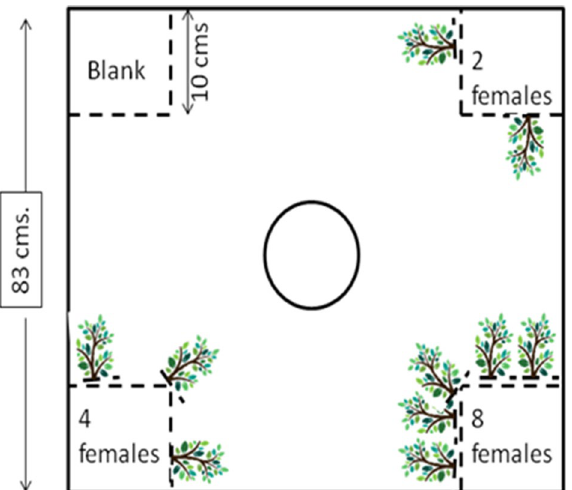
Figure 2. Diagrammatic representation of the arena the vegetation experimental set-up. The central chamber (indicated by a circle) represents the area where the test males were released and the corner square chambers (separated by transparent mesh) contained females of varying density and each patch was associated with variable number of plastic plants representing vegetation